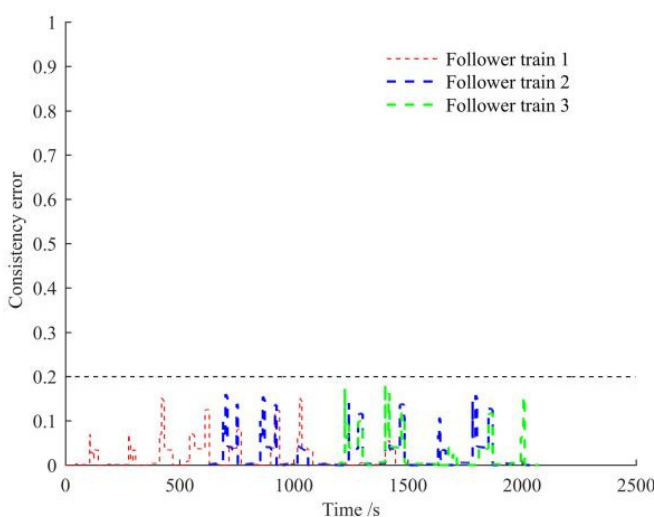
Figure 6. Consistency error of follower trains.